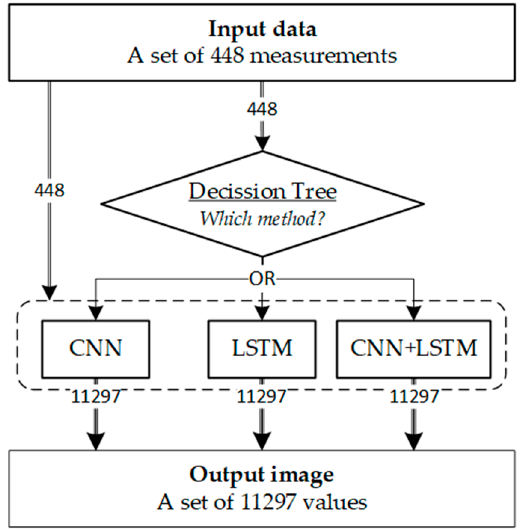
Figure 21. The classifier architecture selects the best model for image reconstruction.